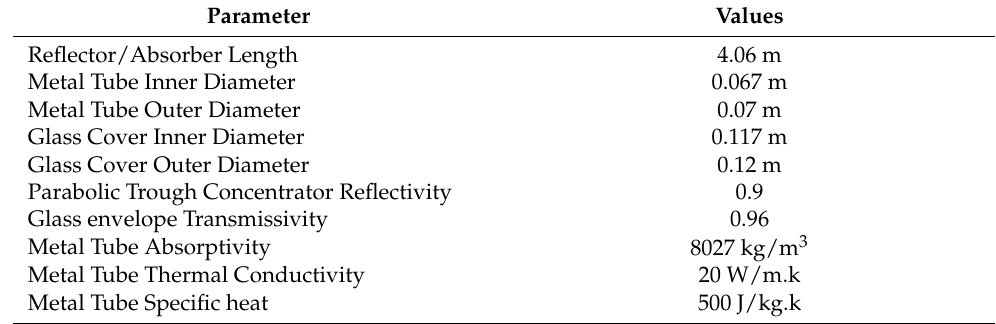
Figure 1. ( a ) Parabolic trough collector (PTC). ( b ) Schematic diagram of cross section of the parabolic trough receiver (PTR) [51]. Reproduced with permission from [51]. Elsevier, 2015. Table 1. Optical parameters of the PTR